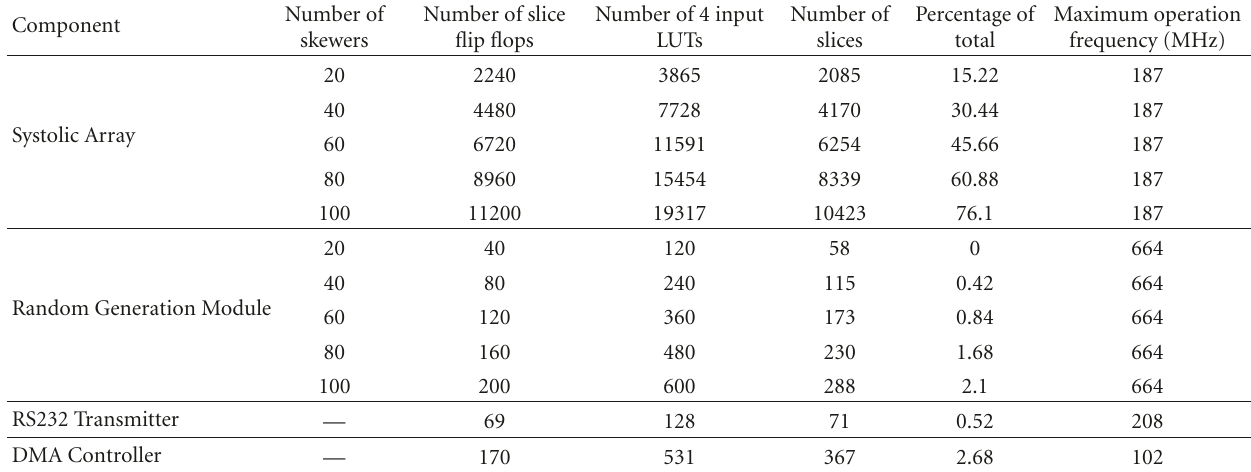
Table 2: Summary of resource utilization for the FPGA-based implementation of the PPI algorithm.